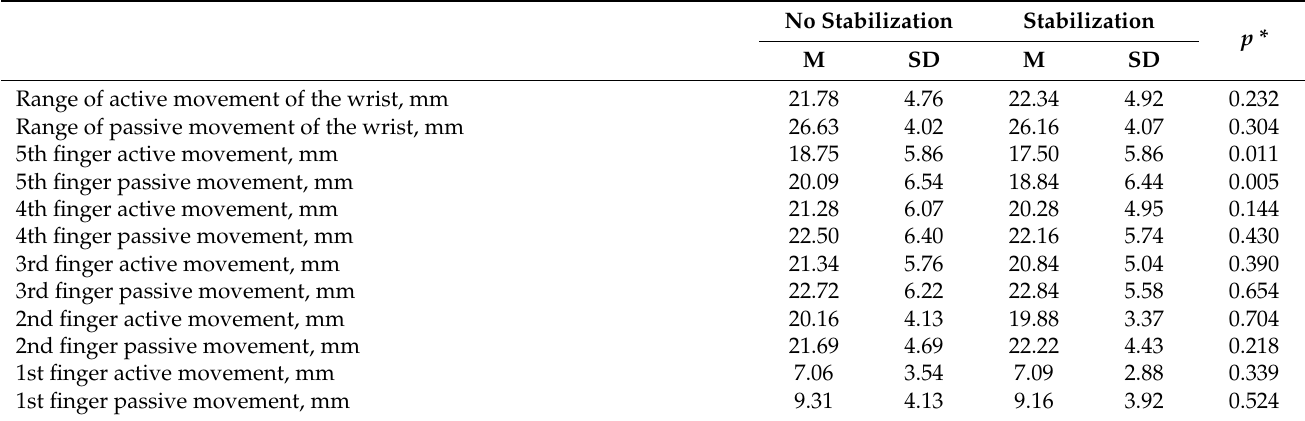
Table 3. Motor coordination of the hand and wrist in neurologically healthy subjects with and without stabilization of the trunk and upper